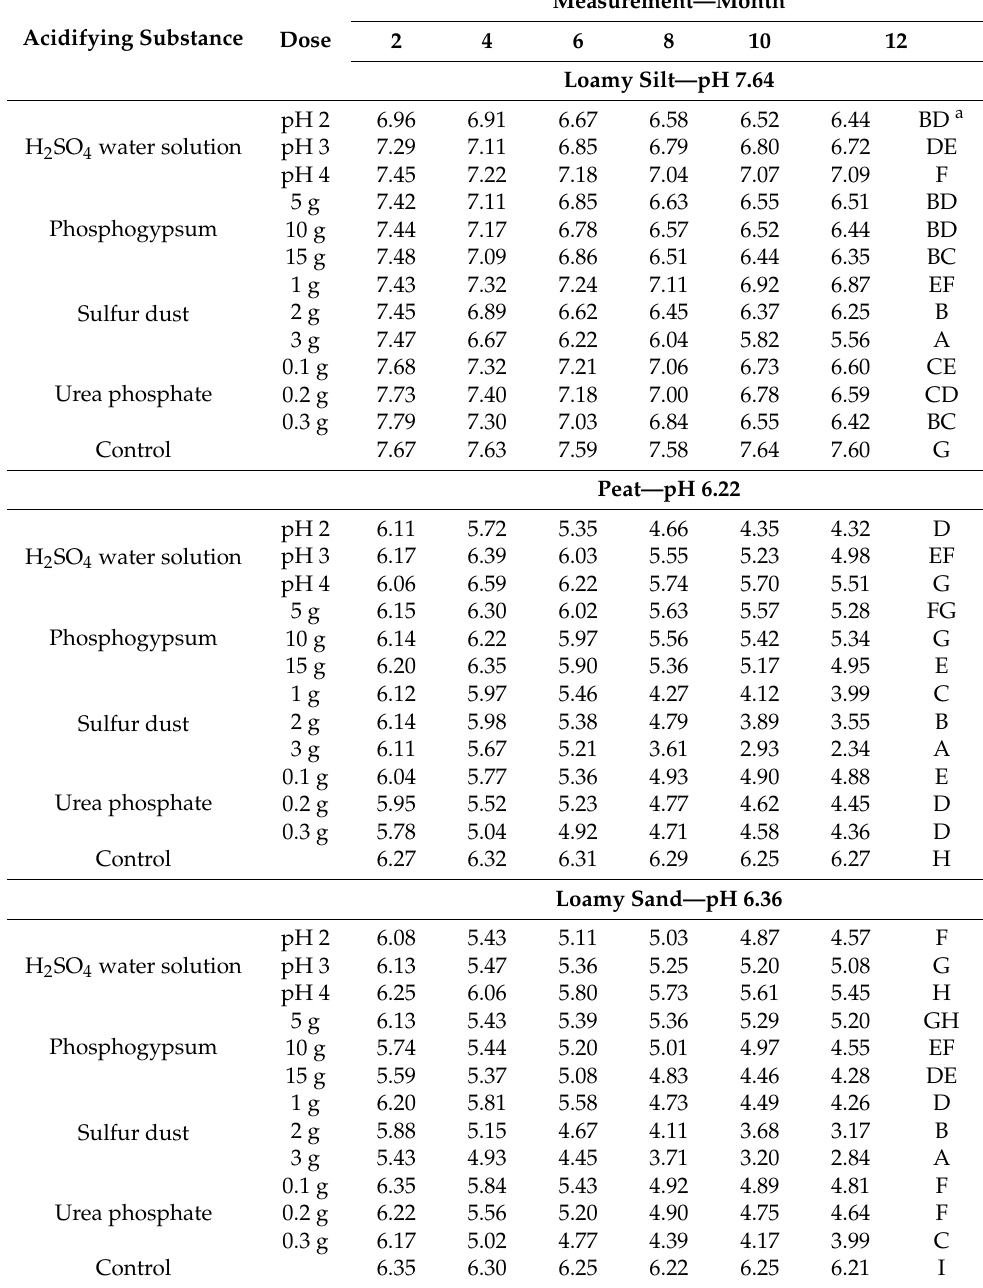
Table 1. Effect of acidifying substances on the change in pH of loamy silt, peat and loamy